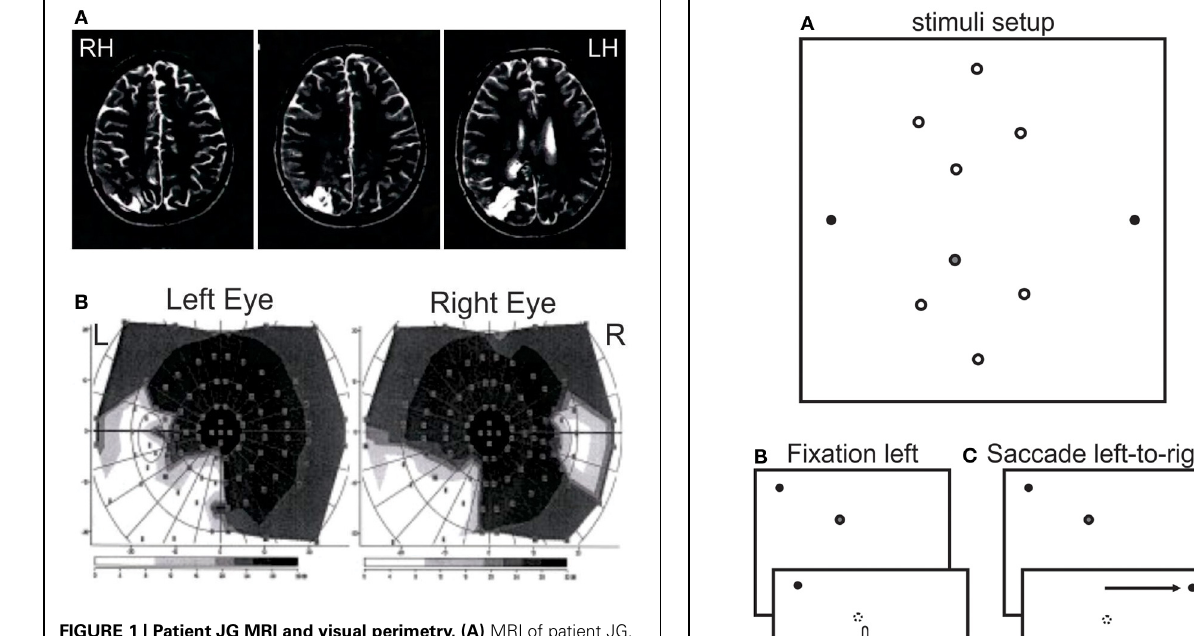
right sessions were as follows. Participants were asked to fixate